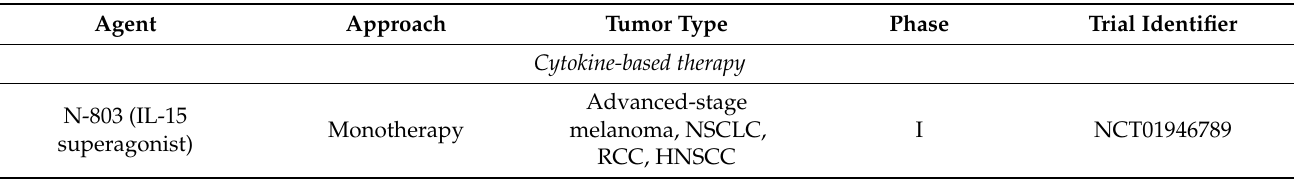
Figure 3. Strategies to harness NK cells in control of metastasis. Each therapeutic strategy is evaluated in isolation or in combination, and even in combination with other strategies including standard treatment. Abbreviations: ADCC, antibody-dependent cellular cytotoxicity; mAbs, monoclonal antibodies. (Arrows indicate enhancement). Table 1. Selected clinical trials of NK-cell-based tumor therapy. Data source ClinicalTrials.gov (www.clinicaltrials.gov, accessed on 18 November 2022).